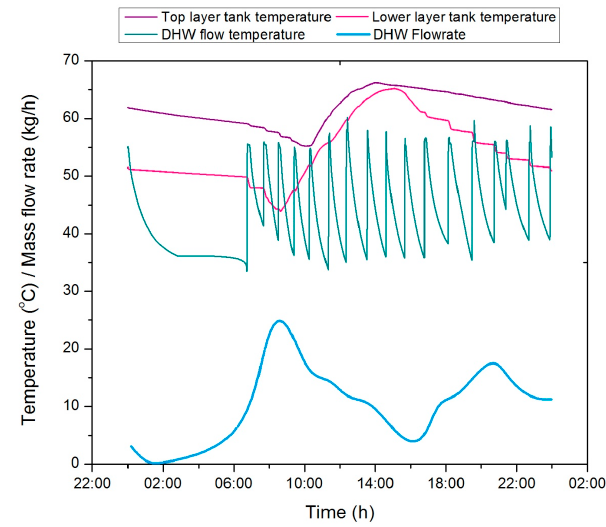
Figure 14. Twenty-four-hour operation profile of DHW preparation.